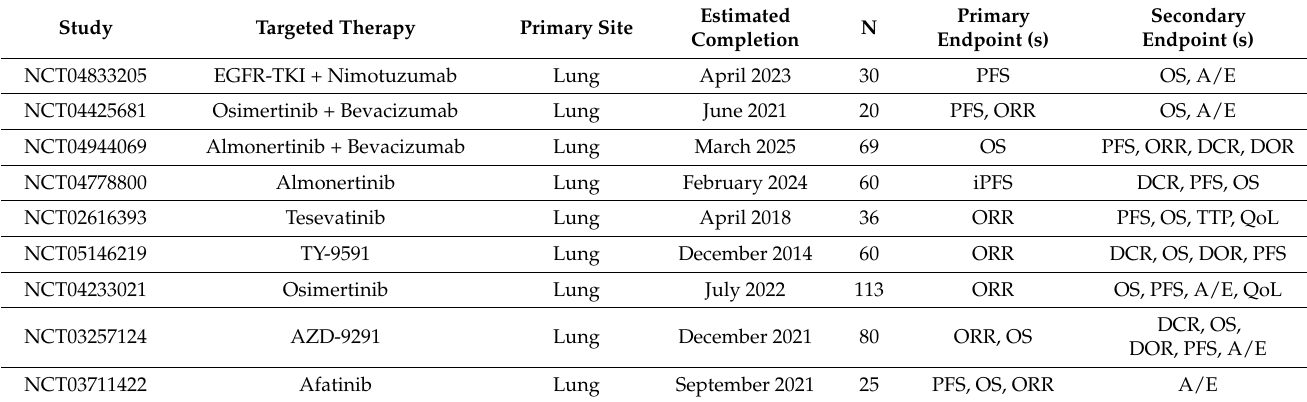
Table 4. Overview of clinical trials evaluating targeted therapy in neoplastic meningitis. Original table, updated till October 2022. Abbreviations: OS: Overall survival, PFS: Progression-free survival, DCR: Disease control rate, DOR: Duration of response, A/E: Adverse Effects, QoL: Quality of